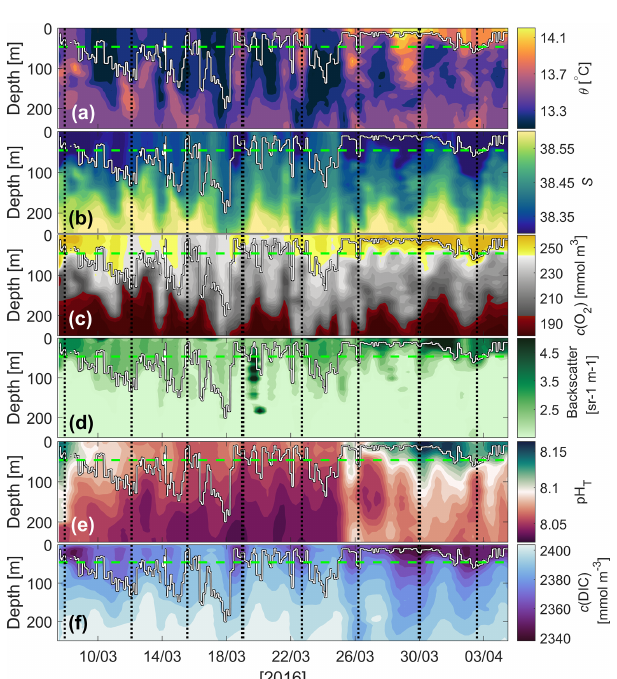
Figure 5. Glider (a) potential temperature ( θ ), (b) salinity, (c) dis- solved oxygen concentration ( c( O 2 ) ), (d) optical backscatter, (e) pH T and (f) dissolved inorganic carbon concentration ( c( DIC ) ). The mean euphotic depth used for calculating N (green dashed line, z lim = 46m) and mixed-layer depth (white line; derived using the potential density criteria of the hybrid scheme of Holte and Talley, 2009) are superimposed. The vertical dashed black lines represent the glider reaching the most northerly point of its transects.